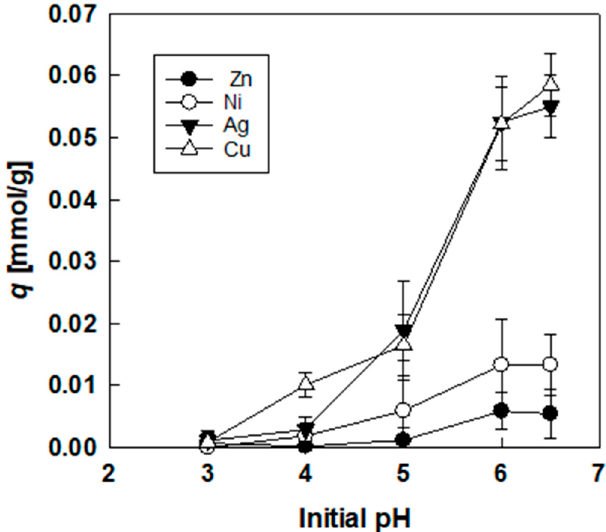
Figure 4. Effect of initial pH on metal adsorption on amidoxime-chitosan hydrogels. (Gel dosage: 0.3 g, agitation speed: 100 rpm, temperature: 30 °C).